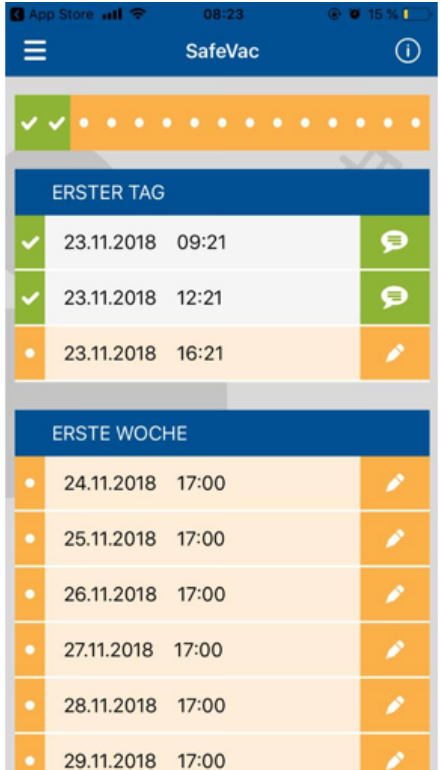
Figure 1. Screenshot of SafeVac